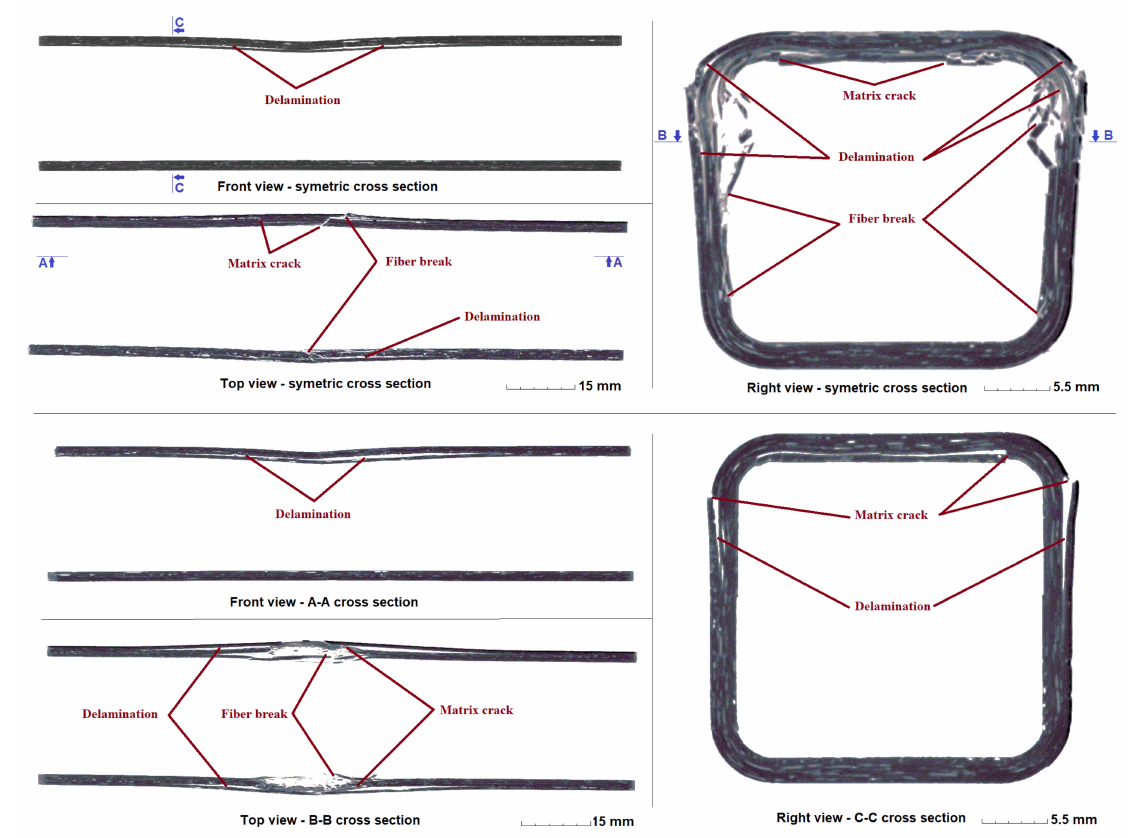
Figure 6. Image of the crushed [ 0 4 ,90 3 ]